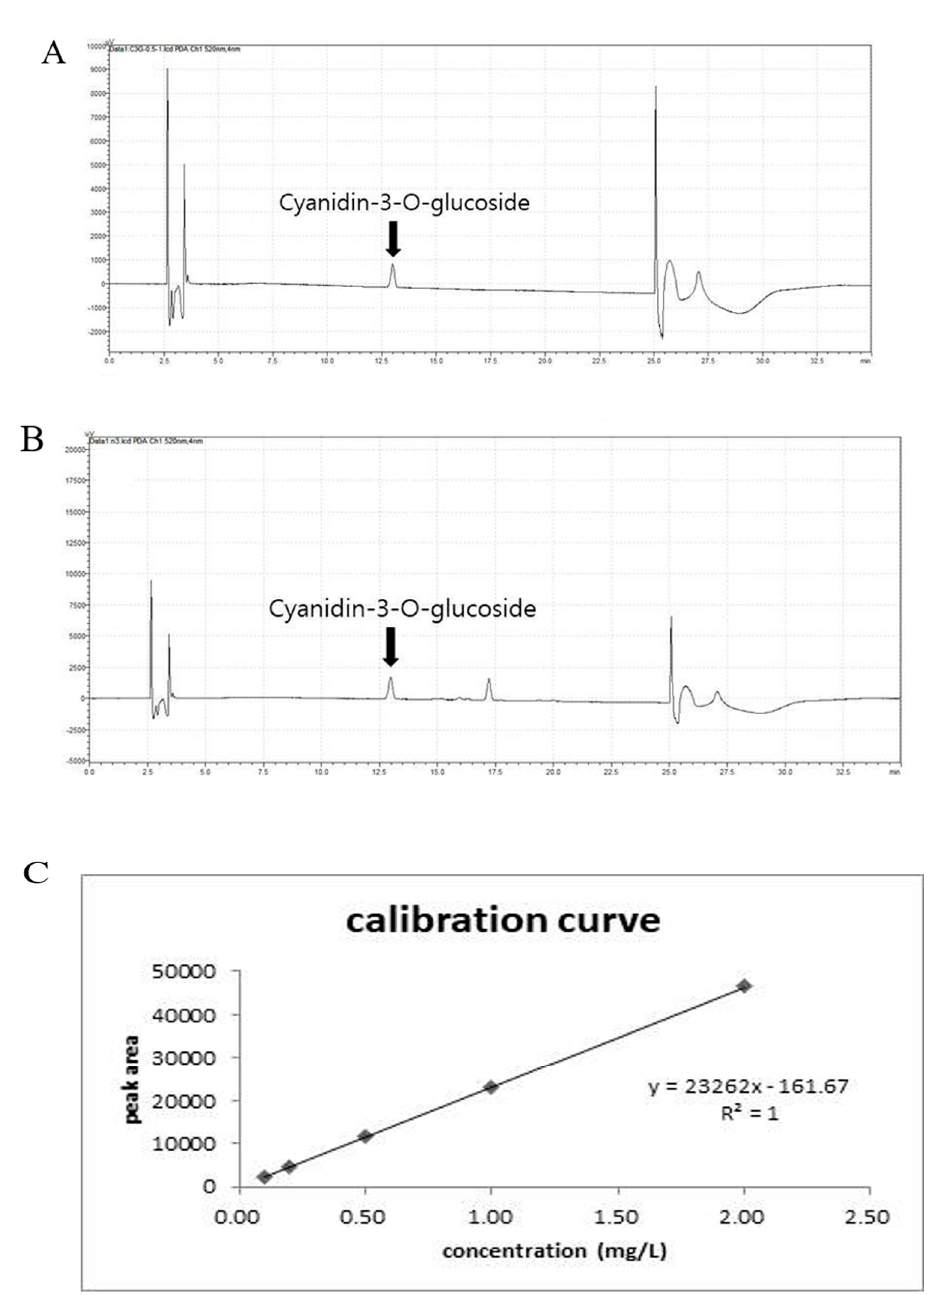
Figure 1. The qualitative identification of anthocyanin in Cheongchunchal (CE). ( A ) High-performance liquid chromatography (HPLC) profiles of CE at 1 mg / L. ( B ) HPLC profiles of anthocyanin at 1 mg / L. The X -axis represents the retention time (min), and the Y -axis represents the absorption units ( µ V). ( C ) Standard curve of anthocyanin at 0.1, 0.2, 0.5, 1, and 2 µ g / mL. The detector was set at 520 nm.